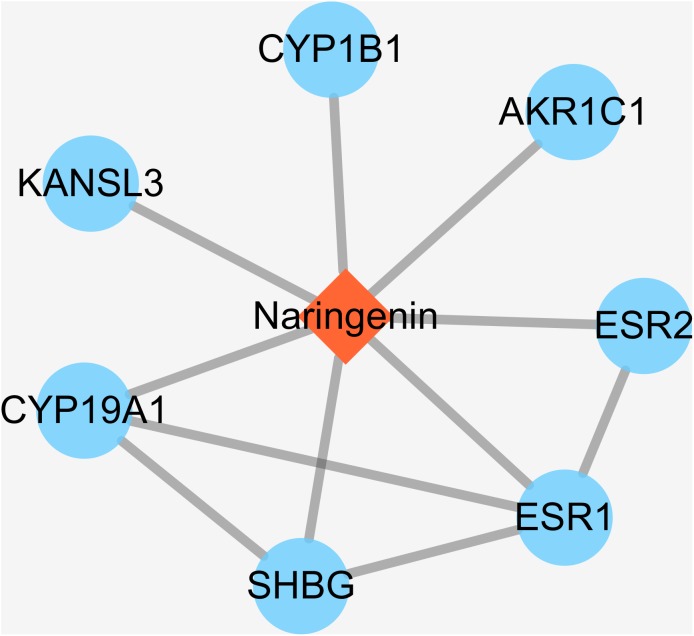
The interactions of naringenin and its DPTs.